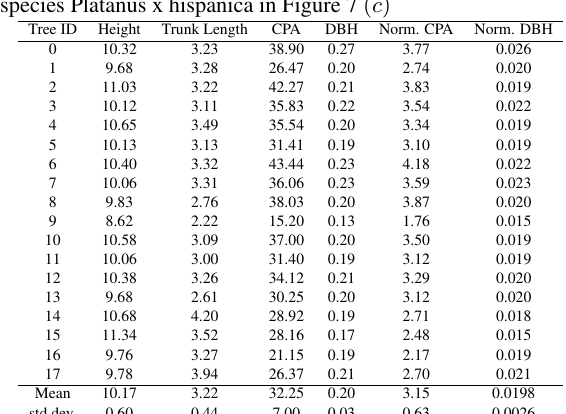
Table 3: Tree parameter estimation results from the trees